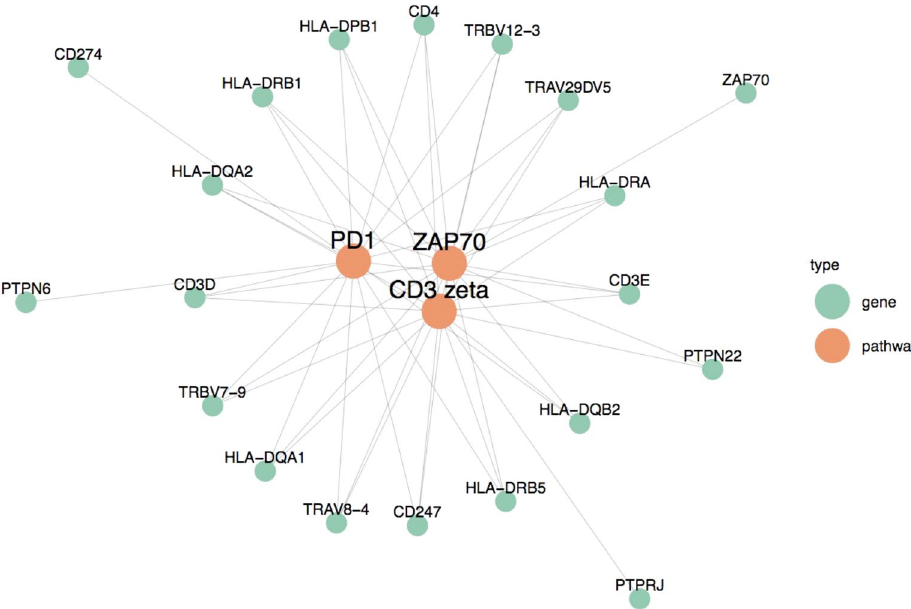
Figure 2. T-cell receptor signaling. This network diagram outlines the overlap of genes shared between critical TCR pathways including PD-1, CD3 phosphorylation and ZAP70 translocation. Edges connect SNV enriched genes to the pathways they are involved in, and show all genes that are involved in all three pathways. HLA- DRB1, HLA-DRA and HLA-DRB5 are shared by all three of these pathways.